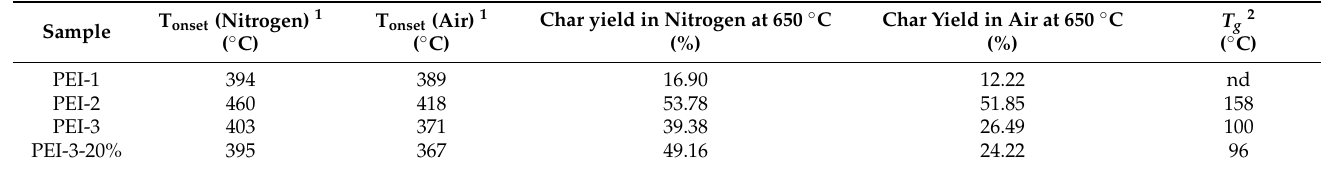
Table 1. Thermal characteristics in nitrogen and air and glass transition temperature of the PEI (1–3) and PEI ‐ 3 ‐ 20% composite film.